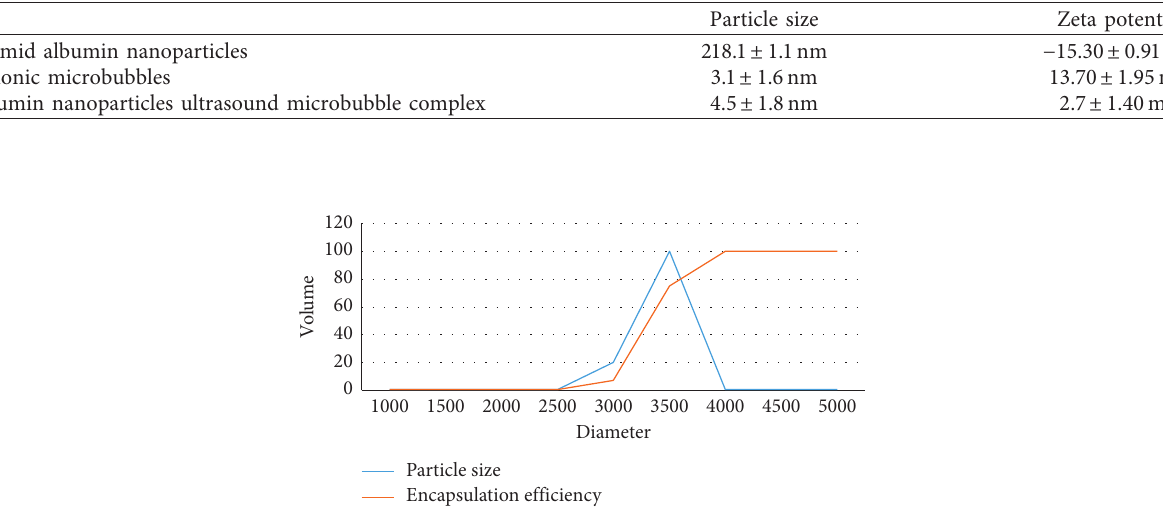
Figure 1: Analysis of particle size of Zetasizer 3000